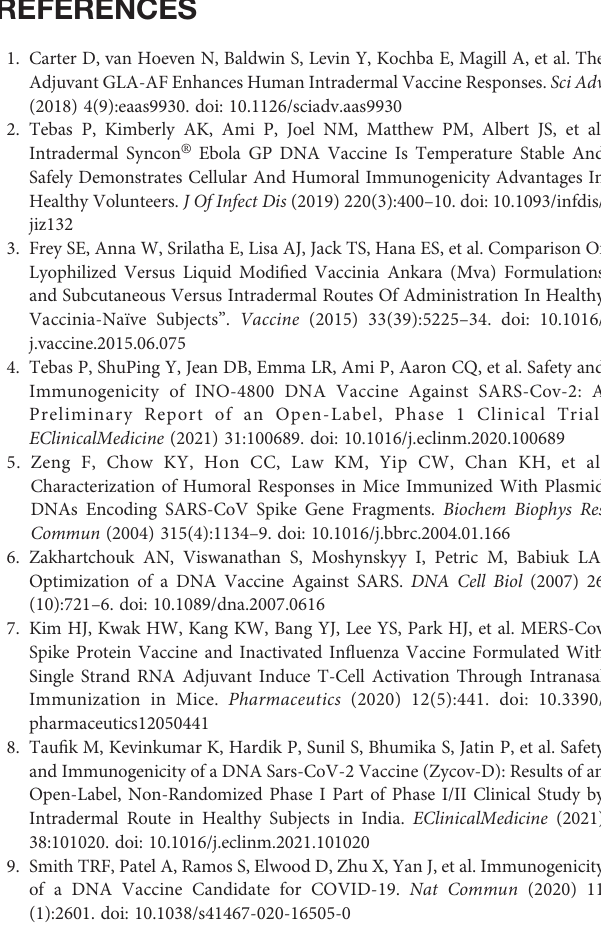
Supplementary Figure 4 | Pro fi le of CD4 + and CD8 + T cell response after immunization. Lymphocytes isolated from the draining popliteal lymph node after